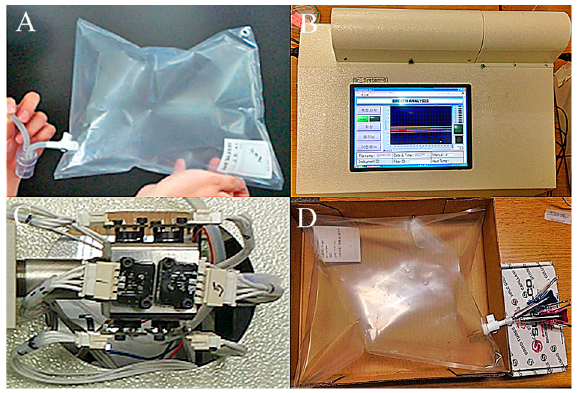
Figure 1. Collection and analysis of exhaled breath. ( A ) Collection of exhaled breath into a 3 L Tedlar bag using a mouth-piece; ( B ) Exhaled breath sensor system for clustering exhaled breath samples; ( C ) Gas sensors placed on the metal-oxide semiconductor; ( D ) Pre-concentration of chemical compounds in the exhaled breath samples using solid phase microextraction (SPME) fiber. Table 1. Demographic and clinical data of the participants in the study.